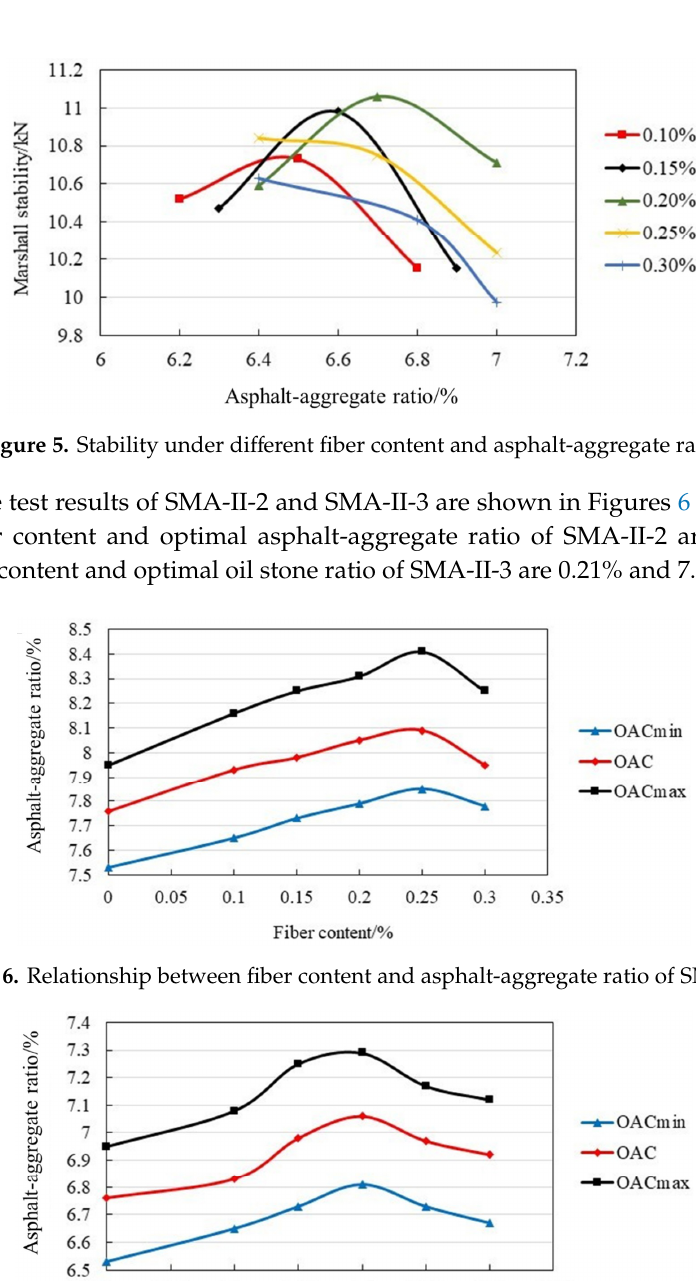
Figure 4. Relationship between fiber content and asphalt-aggregate ratio of SMA- Ⅱ -1. In Figure 4, before the peak of the curve, the optimal asphalt content (OAC) increases with increasing fiber content . At the peak, OAC increases by about 0.4% because of the presence of the